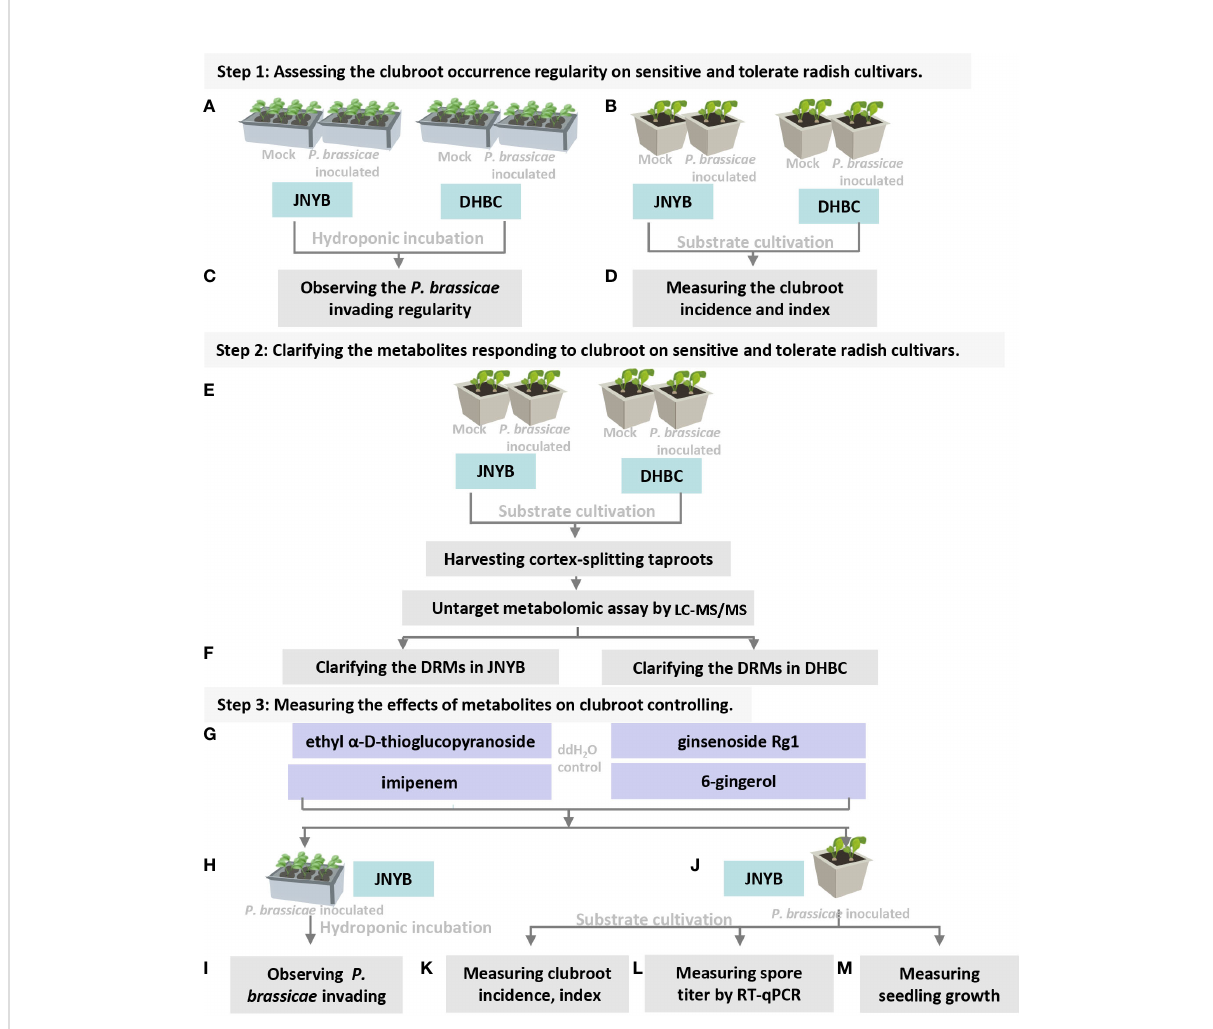
FIGURE 1 Flowchart of present study. (A) Inoculation of P. brassicea spore to hydroponic cultured “ JNYB ” and “ DHBC ” . (B) Inoculation of P. brassicea spore to substrate cultivated “ JNYB ” and “ DHBC ” . (C) Observation of P. brassicea invading to root hairs of two radish cultivars. (D) Clubroot disease incidence and index measurement of two radish cultivars. (E) Inoculation of P. brassicea spore to substrate cultivated “ JNYB ” and “ DHBC ” , collecting cortex-splitting root samples for LC-MS/MS measurement. (F) Clari fi cation of differentially regulated metabolites in two cultivars. (G) Four differentially regulated metabolites were selected for the following studies. (H, J) Application of selected metabolites in hydroponic and substrated cultivation of “ JNYB ” radish. (I) Observation of metabolites ’ effects on P. brassicea invading to root hairs. (K – M) Mearument of metabolites ’ effects on clubroot diseased severity, P. brassicea proliferation, and radish growth. The ddH2O treatment was used as control in this